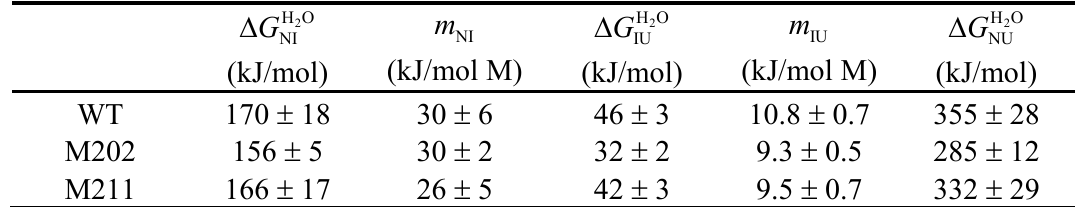
Table 2. Thermodynamic parameters of the three-state unfolding of the WT TcSOD and the